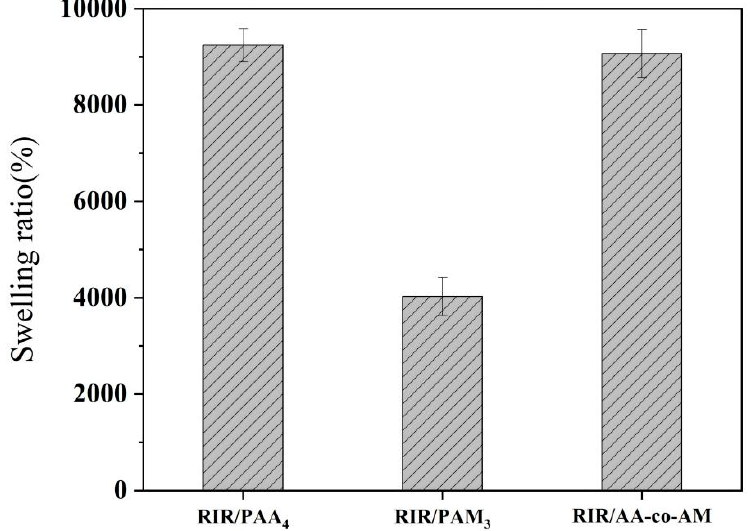
Figure 6. The swelling ratio of RIR/PAA 4 , RIR/PAM 3 , and RIR/AA-co-AM.